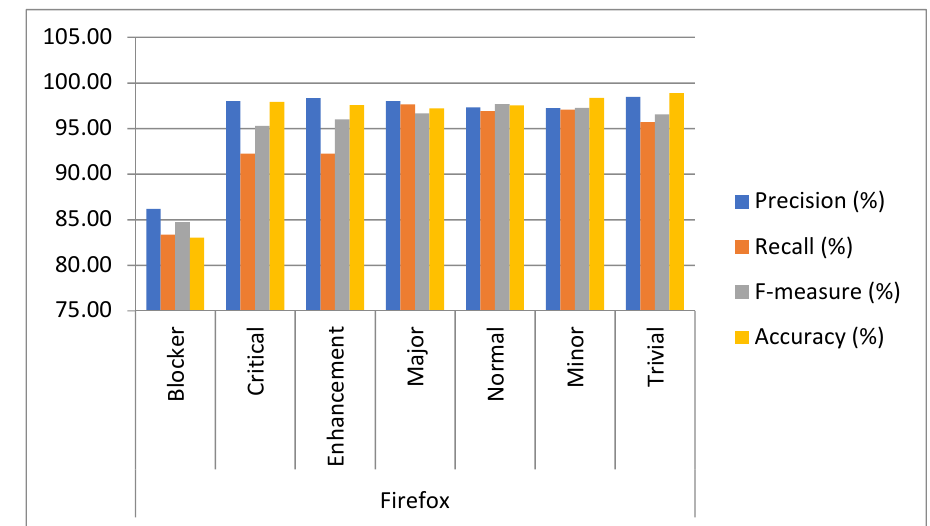
Figure 5. Results analysis of the proposed BCR on seven classes of the Mozilla Project.